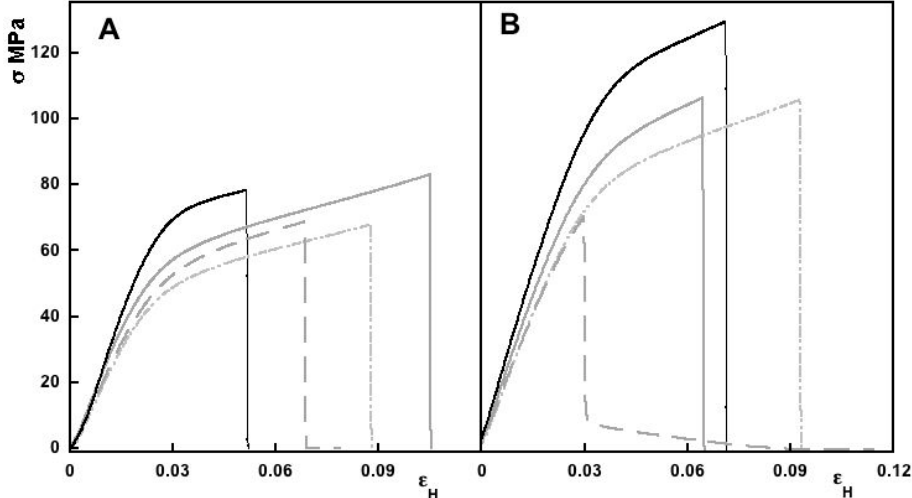
Figure 5. Representative tensile stress ( σ )–Hencky strain ( ε H ) curves obtained for the different films: A (solid black line), A-T (solid grey line), A-T-LEO L (dashed and dotted grey line) and A-T-LEO H (dashed grey line) without ( A ) and with ( B ) CaCl 2 .